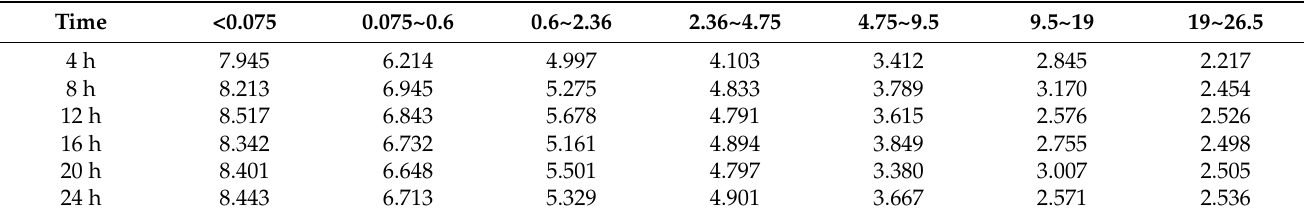
Table 5. Cr precipitation (mg/L).